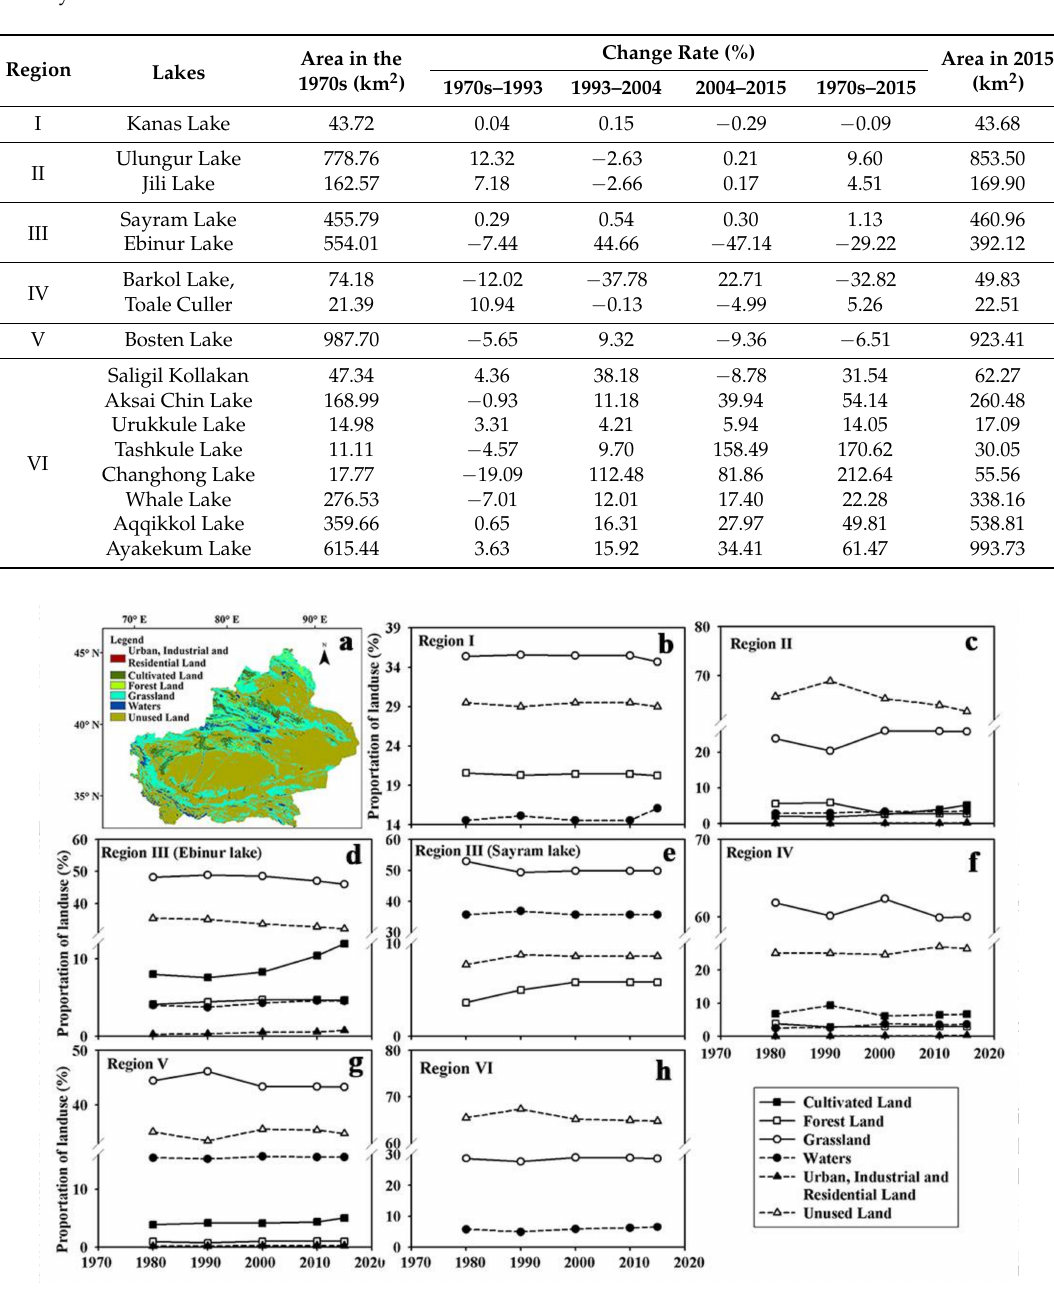
Figure 6. Landuse map of Xinjiang in 2015 ( a ) and variations in landuse during 1980 to 2015 in each region ( b – h